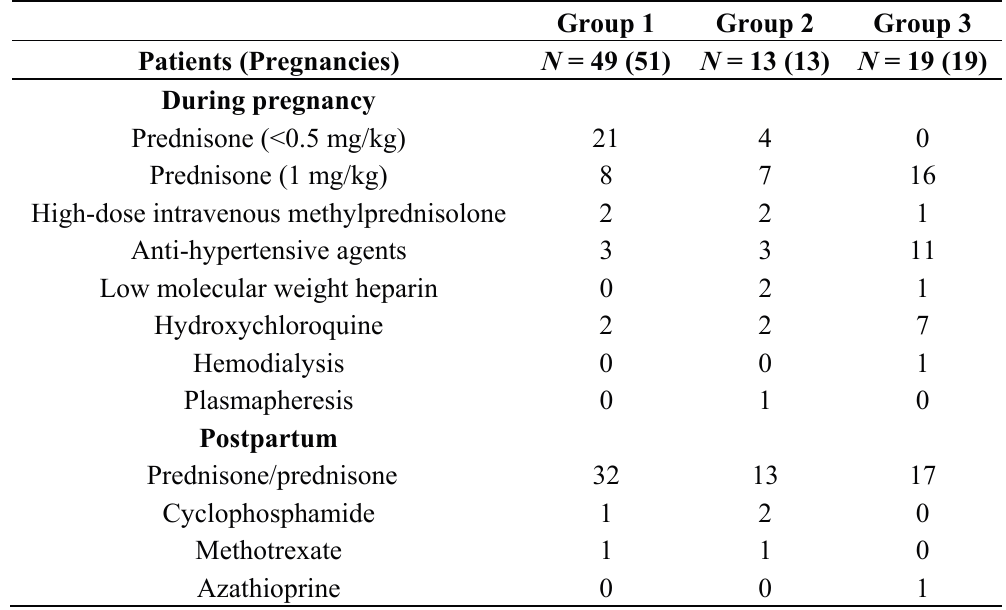
Table 4. Therapy of SLE patients during pregnancy and